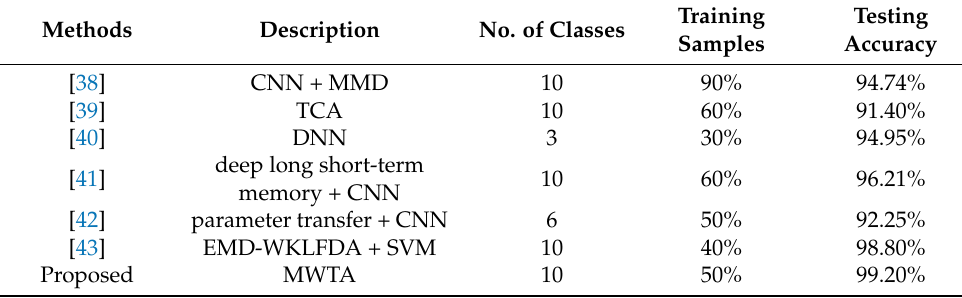
Table 4. The fault identification results of the proposed method and published